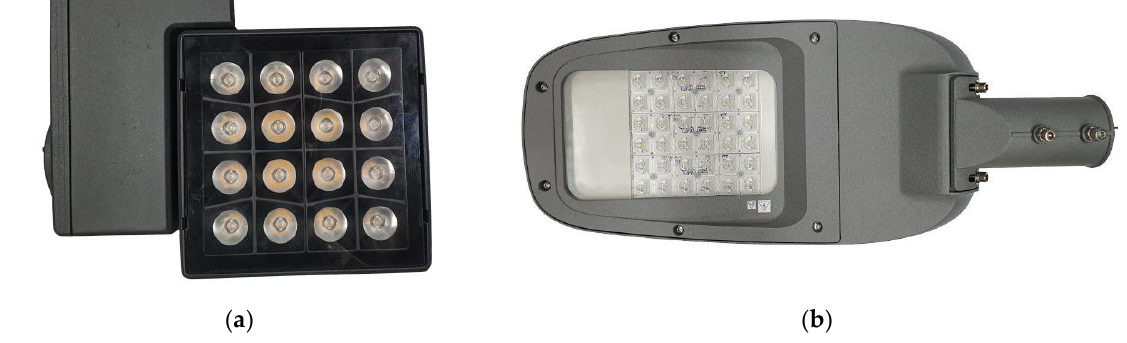
Figure 1. Multi-source high-power LED luminaires: ( a ) floodlight and ( b ) street luminaire.